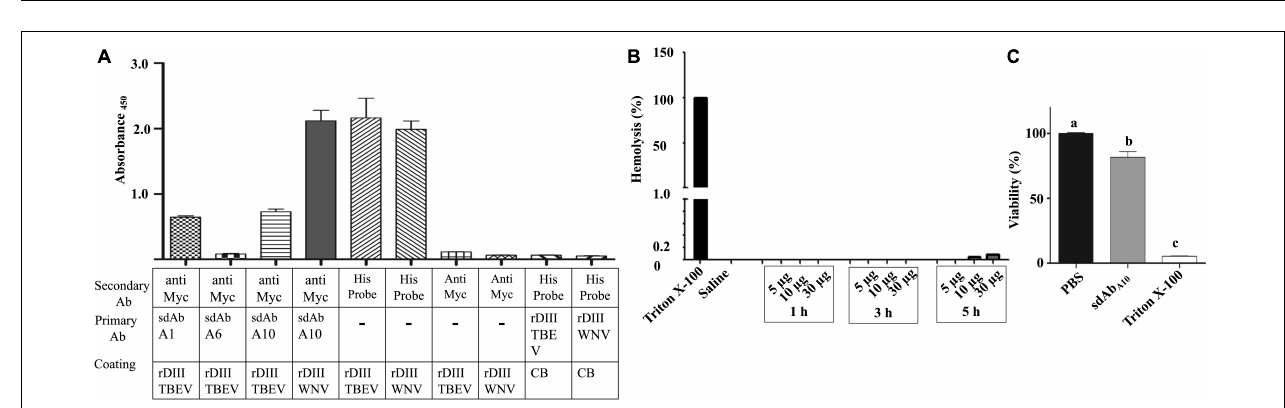
FIGURE 5 | Neutralization of West Nile virus (WNV)-like particles (WNV-VLP) by sdAbs. (A) virus neutralization test used to assess the ability of sdAb A1 , sdAb A6 , and sdAb A10 to neutralize the WNV-VLP. Hyperimmune serum of horse (positive control), sdAb A3 (sdAb that does not block the binding of DIII to hBMEC), and non-related sdAb (negative control – VHH F3 raised against N. meningitidis ) were used in the same assay. (B) The amount of sdAb (nanograms) required to neutralize the WNV-VLP (EC 50 ) was calculated using non-linear regression (dilution of sdAb on Y -axis and quantity sdAbs in nanograms on X -axis) in Graphpad Prism 8 software. The concentration of sdAb in nanograms per well, per ml, and corresponding molar concentrations are tabulated.